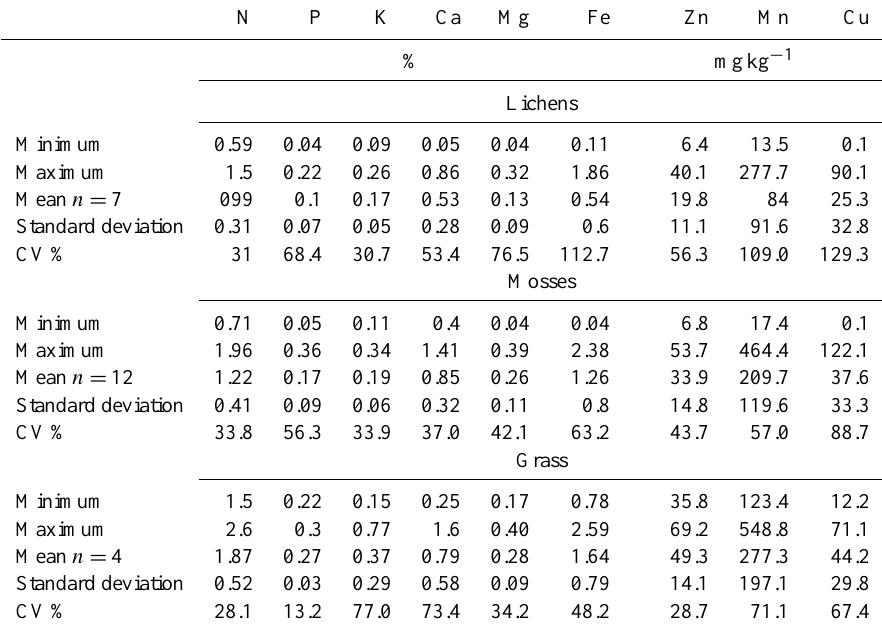
Table 5. Range and mean values of macro- and micronutrients in lichens, mosses and D. antarctica of ice-free areas on Potter Peninsula.